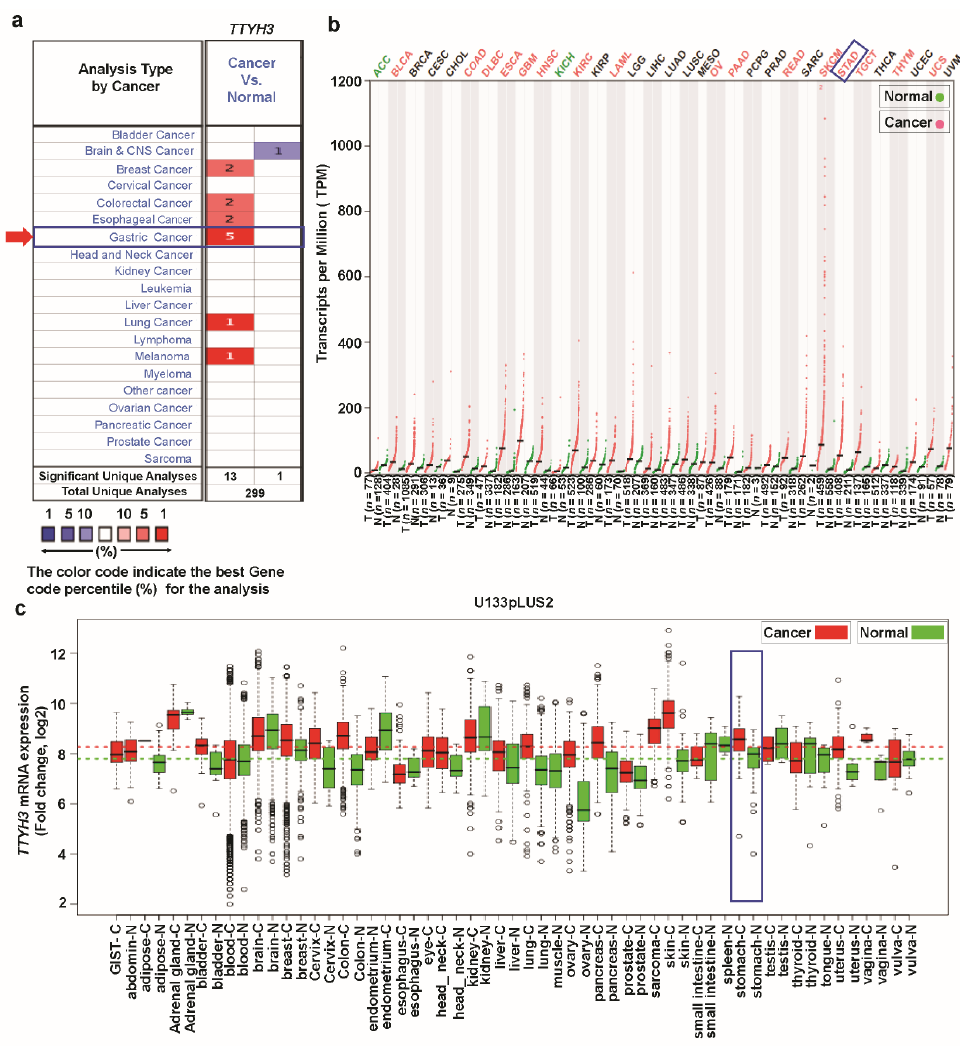
Figure 1. TTYH3 mRNA expression in various cancer types: ( a ) The comparison indicated the number of datasets with TTYH3 mRNA overexpression (left column, red) and underexpression (right column, blue) in cancers versus normal tissues. This graphic presentation originated from the Oncomine database (available at https: // www.oncomine.org / resource / login.html), and the threshold was designed with the following parameters: p -value of 1E − 4, fold-change of 2, and gene ranking of 10%. ( b ) The expressions of TTYH3 in 33 types of human cancer in data from The Cancer Genome Atlas through GEPIA2 (Gene expression Profiling Interactive Analysis 2) web (available at https: // gepia2.cancer-pku.cn): The gene expression profile across all tumor samples and paired normal tissues is shown as a dot plot. Each dot represents expression of samples. ( c ) Expression pattern of TTYH3 mRNA in tumor and corresponding normal tissue: Data concerning TTYH3 mRNA expression in various types of cancer were retrieved from the GENT (Gene Expression across Normal and Tumor tissue) database (available at http: // medical-genomics.kribb.re.kr / GENT / ). Boxes represent the median and the 25th and 75th percentiles. Dots represent outliers. Red boxes represent tumor tissues, and green boxes represent normal tissues. Red and green dashed lines represent the average expression value of all tumor and normal tissues, respectively.